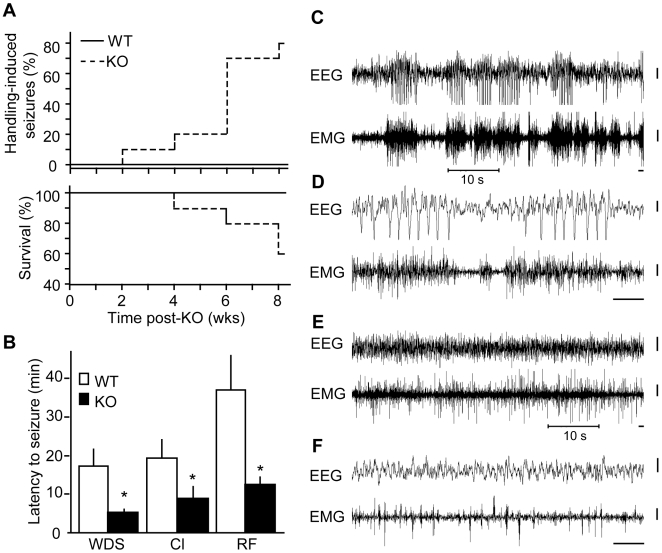
Elevated seizure susceptibility after chronic conditional Cdk5 loss.
A, Kaplan-Meier seizure morbidity and survival curves. Percent of animals observed to have handling-induced seizures and percent survival are plotted against weeks post-KO; n = 10–14; the differences for morbidity and mortality were statistically significant, P<0.01, log-rank test. B, Latency to pilocarpine-induced wet-dog shakes (WDS), clonus (Cl), and rearing/falling (RF) seizures in mice, 8 weeks post-KO (n = 7–10). *P<0.05 vs. WT, Student's t-test. Data represent means±s.e.m. C–F, Representative spontaneous EEG/EMG recordings from a conditional KO mouse, 8 weeks post-KO. C, Appearance of multiple bursts (at 3–4 Hz) of spike waves which were frequently clustered as shown and accompanied by evident tremor and clonic seizures. D, Expanded view of 10 sec of the recording period shown in Figure C, displaying two spike bursts separated by about 2 sec. E, Post-ictally, there was rapid return to normal EEG/EMG and resumption of ongoing activity as displayed here during a period of wakefulness. F, Expanded view of 10 sec of the recording period shown in Figure E, Calibration 1 sec and 50 µV; the recording periods shown in panels D and F are annotated by the 10 sec bars in C and E respectively.